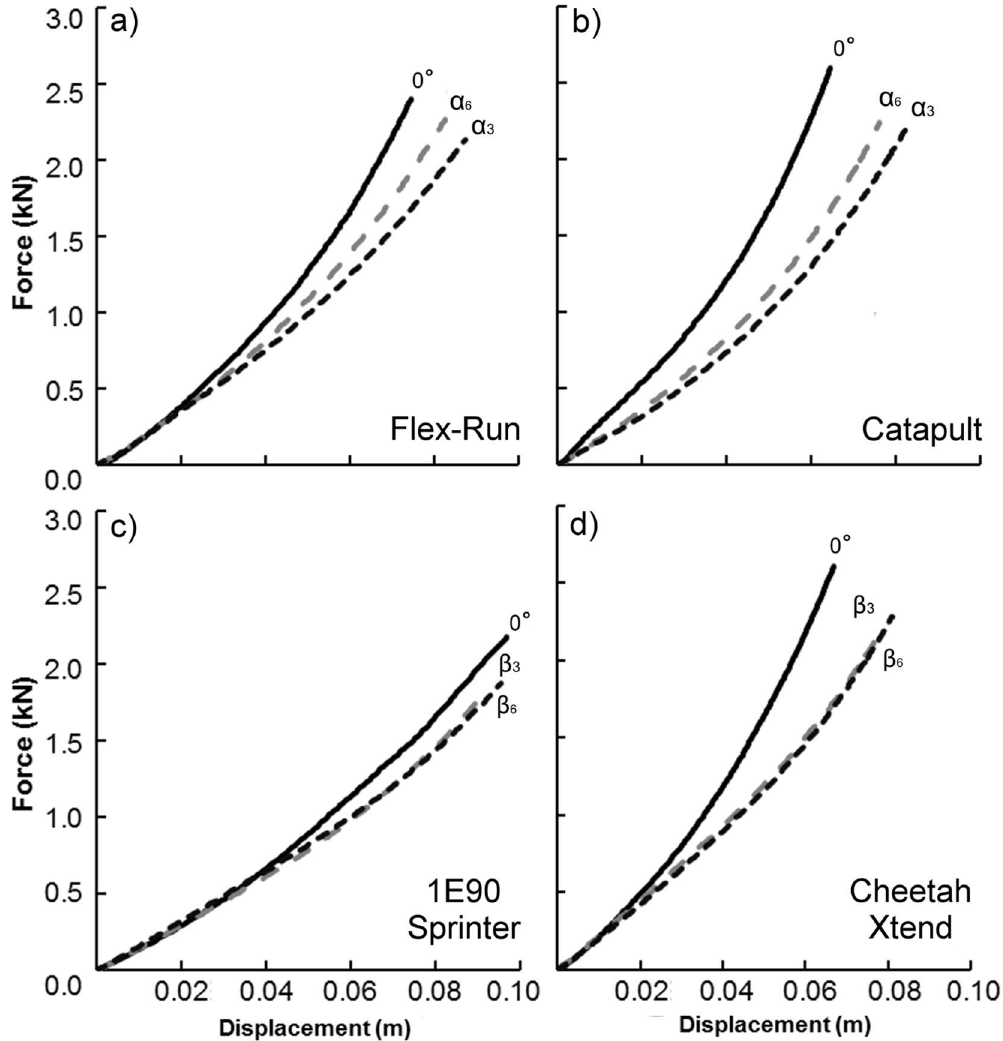
Fig 3. Representative force-displacement profiles for running-specific prosthetic models at each testing angle. Each running-specific prosthesis(RSP) is the manufacturer recommended stiffness category for a 70 kg distancerunner. α 3 and β 3 indicate the measuredangle betweenthe RSP and peak resultant groundreaction force (GRF) vector whilerunning 3 m/s using the C-shapedRSPs (Flex-Runand Catapult)and J-shaped RSPs (1E90 Sprinter and CheetahXtend), respectively. α 6 and β 6 indicatethe measuredangles betweenthe RSP and peak resultant GRF vector while running6 m/s using the C-shapedRSPs and J-shapedRSPs, respectively. a) The Flex- Run prosthesisat testing angles of 0˚, α 3 , and α 6, b) the Catapultprosthesisat testing anglesof 0˚, α 3 , and α 6, c) the 1E90 Sprinter prosthesisat testing angles of 0˚, β 3 , and β 6 , and d) the CheetahXtend prosthesisat testing angles of 0˚, β 3 , and β